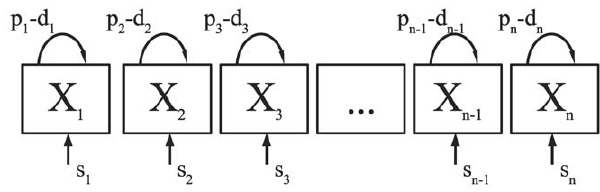
Figure 1. A cartoon of the model with explicit kinetic heterogeneity. In the model, the population of cells consists of n sub-populations with different rates of turnover. In the i th sub- population, there is a source of new cells that enter the cell population at rate s i cells per day, cells divide at rate p i per day, and die at rate d i per day. To maintain the size of all sub-populations constant, d i { p i ~ s i = X i for every sub-population i , where X i is the number of cells in the i th sub-population. In this model we assume that the source produces only labeled cells during the labeling phase, and delabeled cells during the unlabeling phase [11].